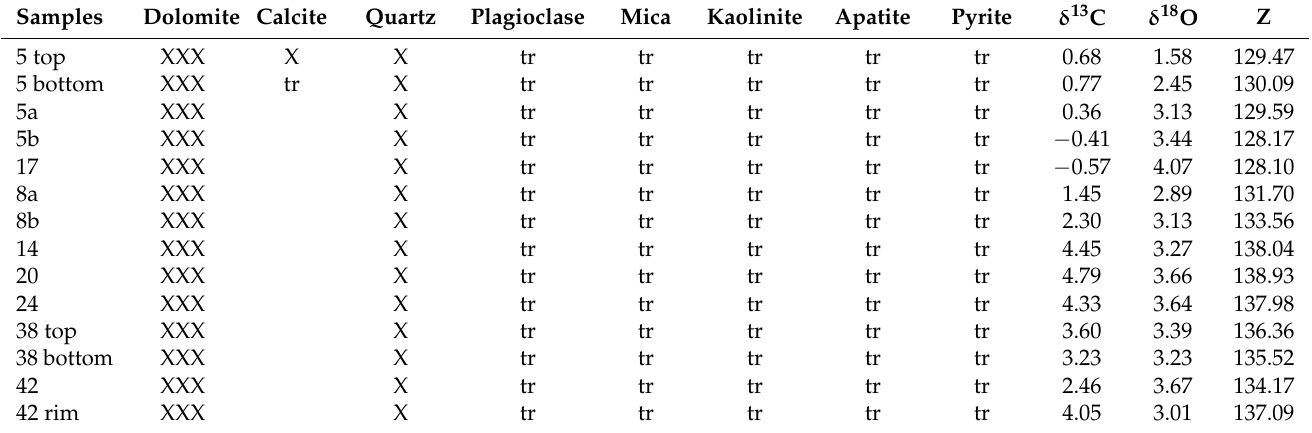
Table 3. Mineralogical composition determined by XRPD and SEM/EDS analyses, values of stable isotopes ( 13 C, 18 O), and Z value of the eight conduit concretions and minerals detected. Z is calculated according to Formula